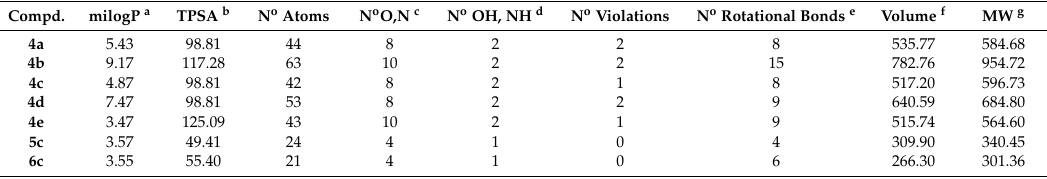
Table 3. Molecular properties prediction-Lipinski “Rule of five. Drug likeness of the more potent representative compounds.